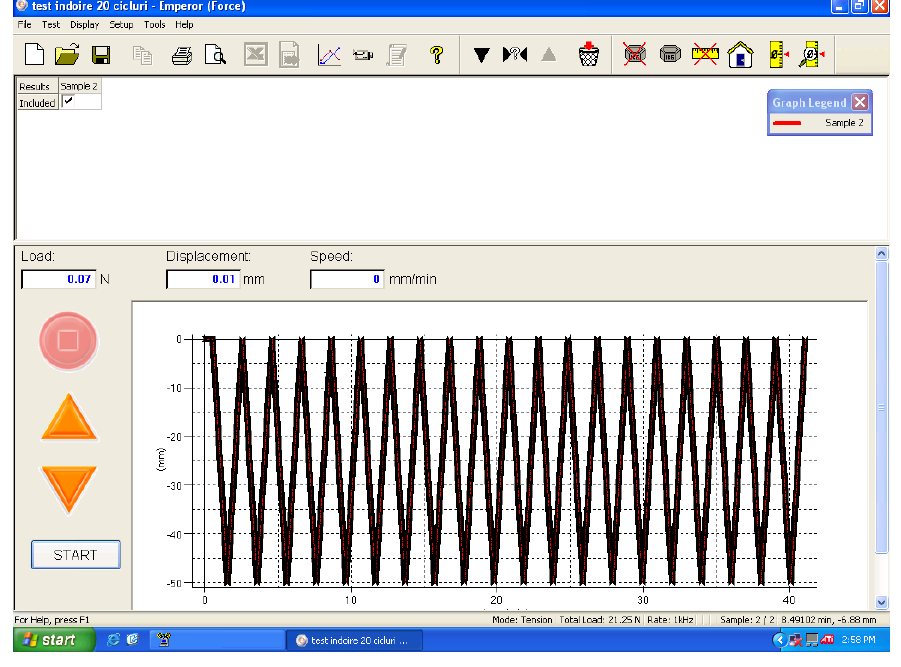
Figure 13. Mecmesin 2.5 I and image of the 20 recorded bending cycles.